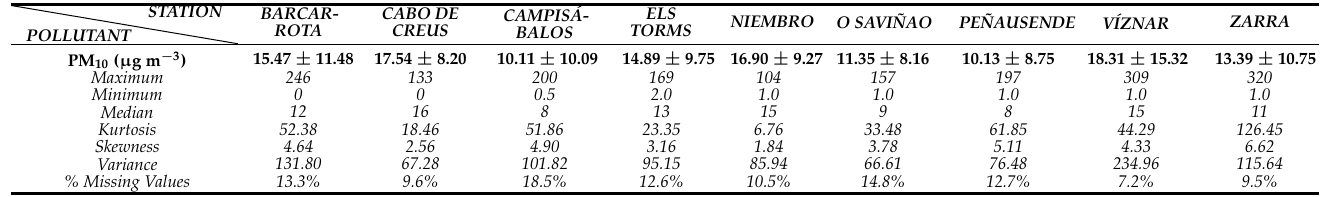
Table 3. Averaged concentration ( ± standard deviation), maximum, minimum, median, kurtosis, skewness, and variance values of the data series covering the period from 2001 to 2019 for each weather station. Percentages of missing data per station are also